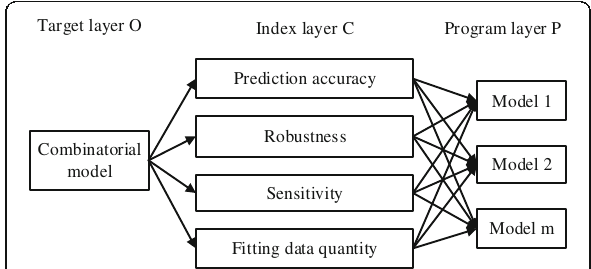
Fig. 1 Hierarchical structure diagram of combined model. As a hierarchical structure diagram, it consists of three layers: target layer, index layer, and program layer. The program layer contains a variety of intelligent model types, and which model should be chosen by the actual needs of the project. The index layer contains a variety of evaluation indexes of the single model: prediction accuracy, robustness, sensitivity, and the amount of data needed to be fitted. These selected indexes can reflect the performance of the